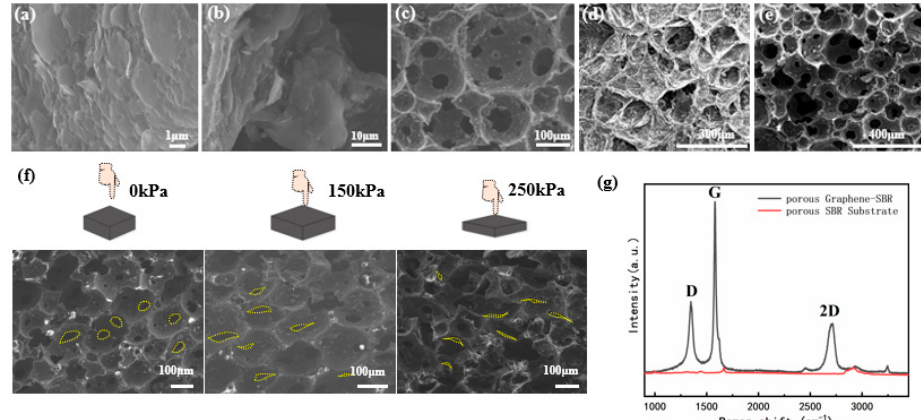
Figure 3. ( a – e ) SEM image of the PGSPS: the magnification increases gradually from ( a ) to ( e ). ( f ) Photographs of squeezed PGSPS, under 0 kPa, 150 kPa, and 250 kPa of pressure, respectively. ( g ) Raman spectra of graphene–SBR and SBR.